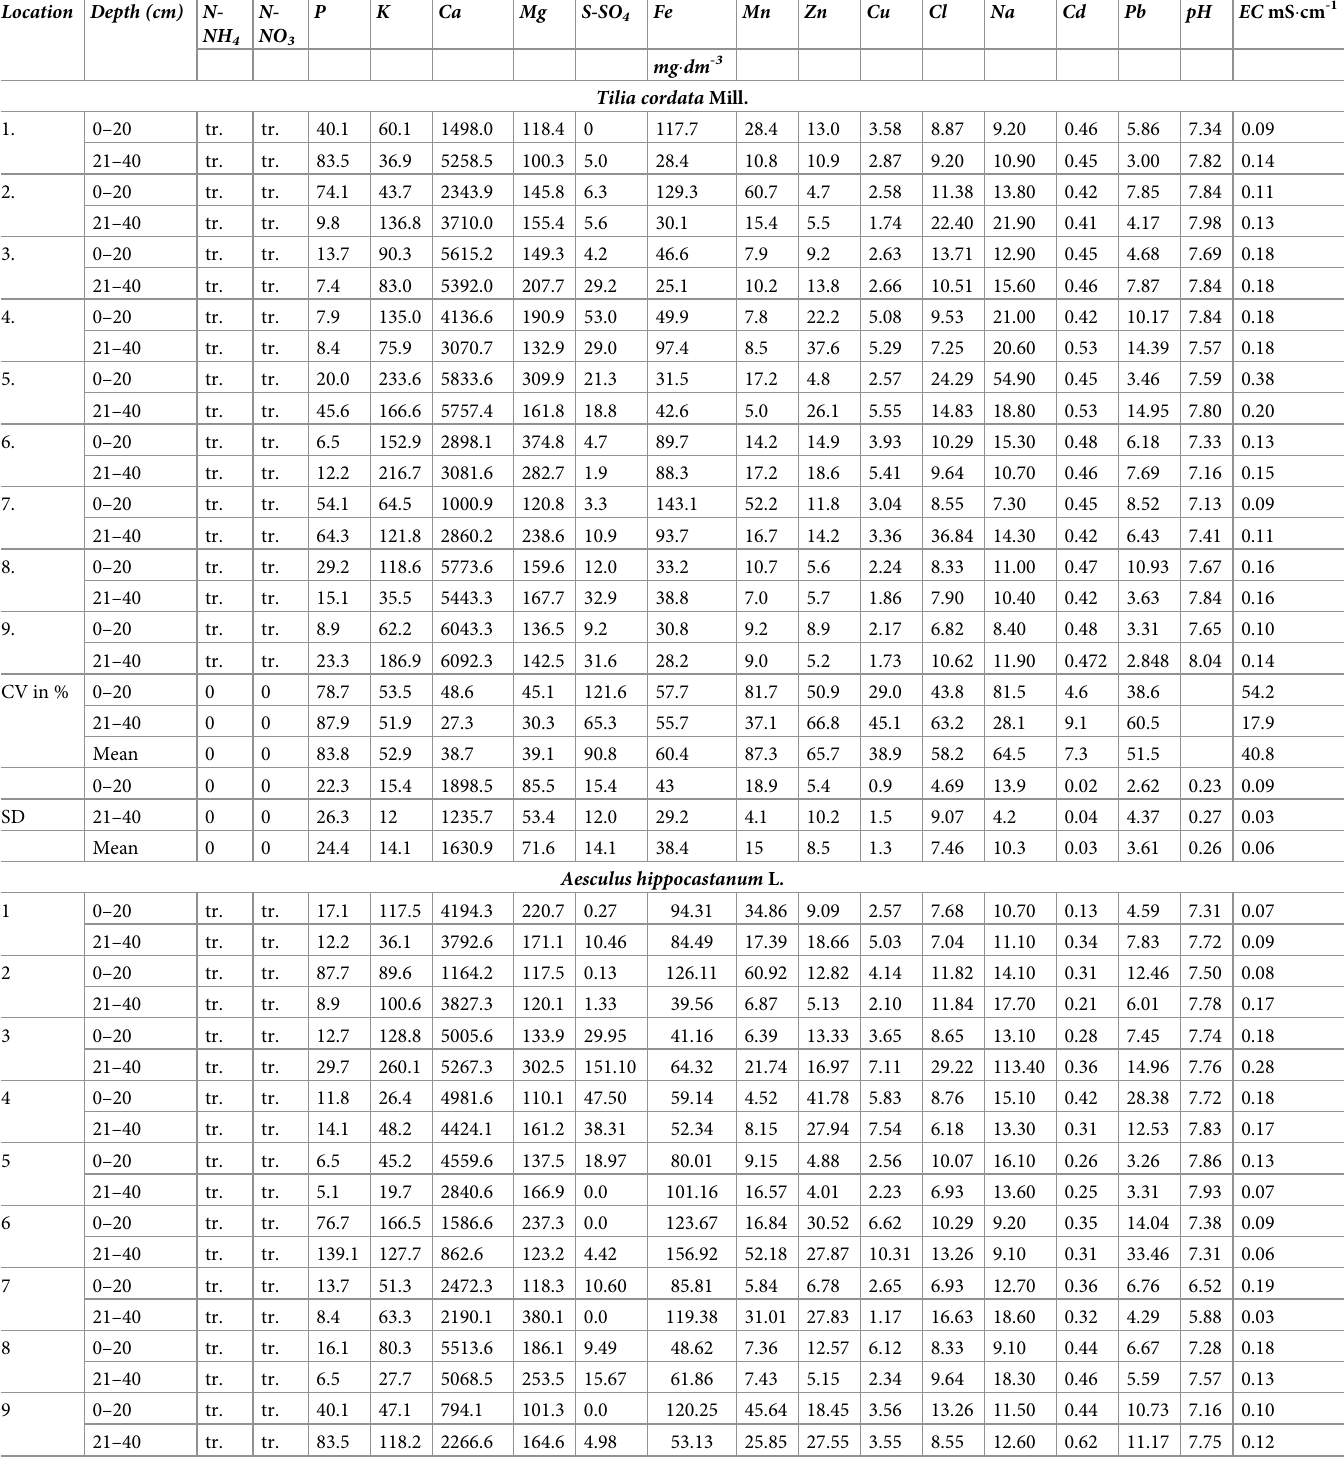
Table 4. Chemical properties of soils and coefficients of their variability on sites of T . cordata Mill. and A . hippocastanum